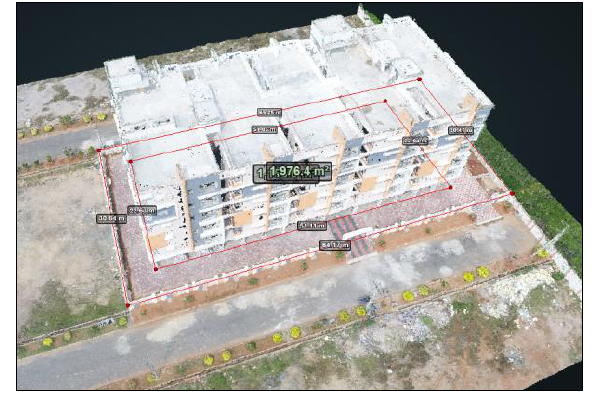
Figure 9: Setback measurement tool included in the 3D viewing webportal.